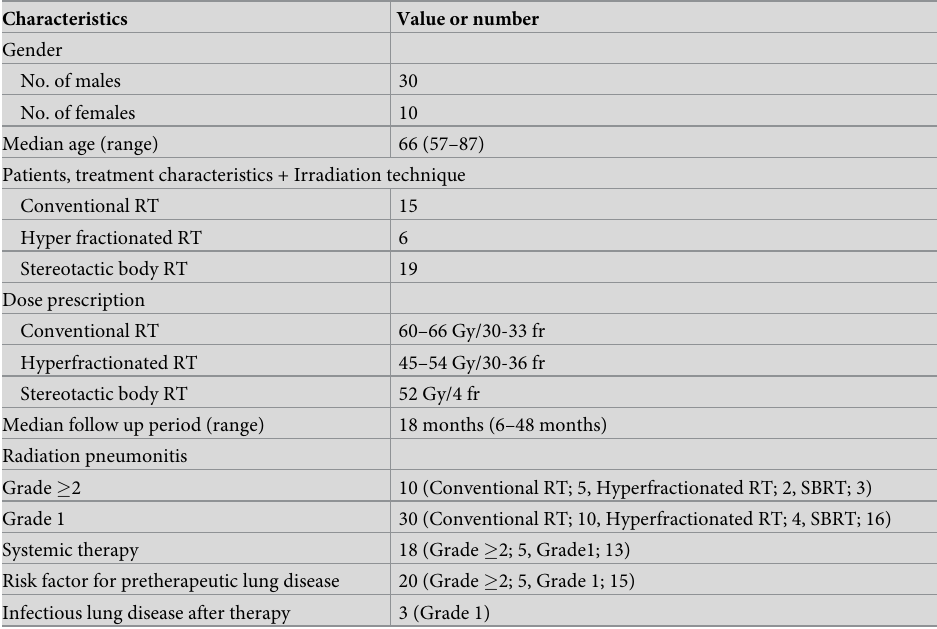
Table 1. Patients’